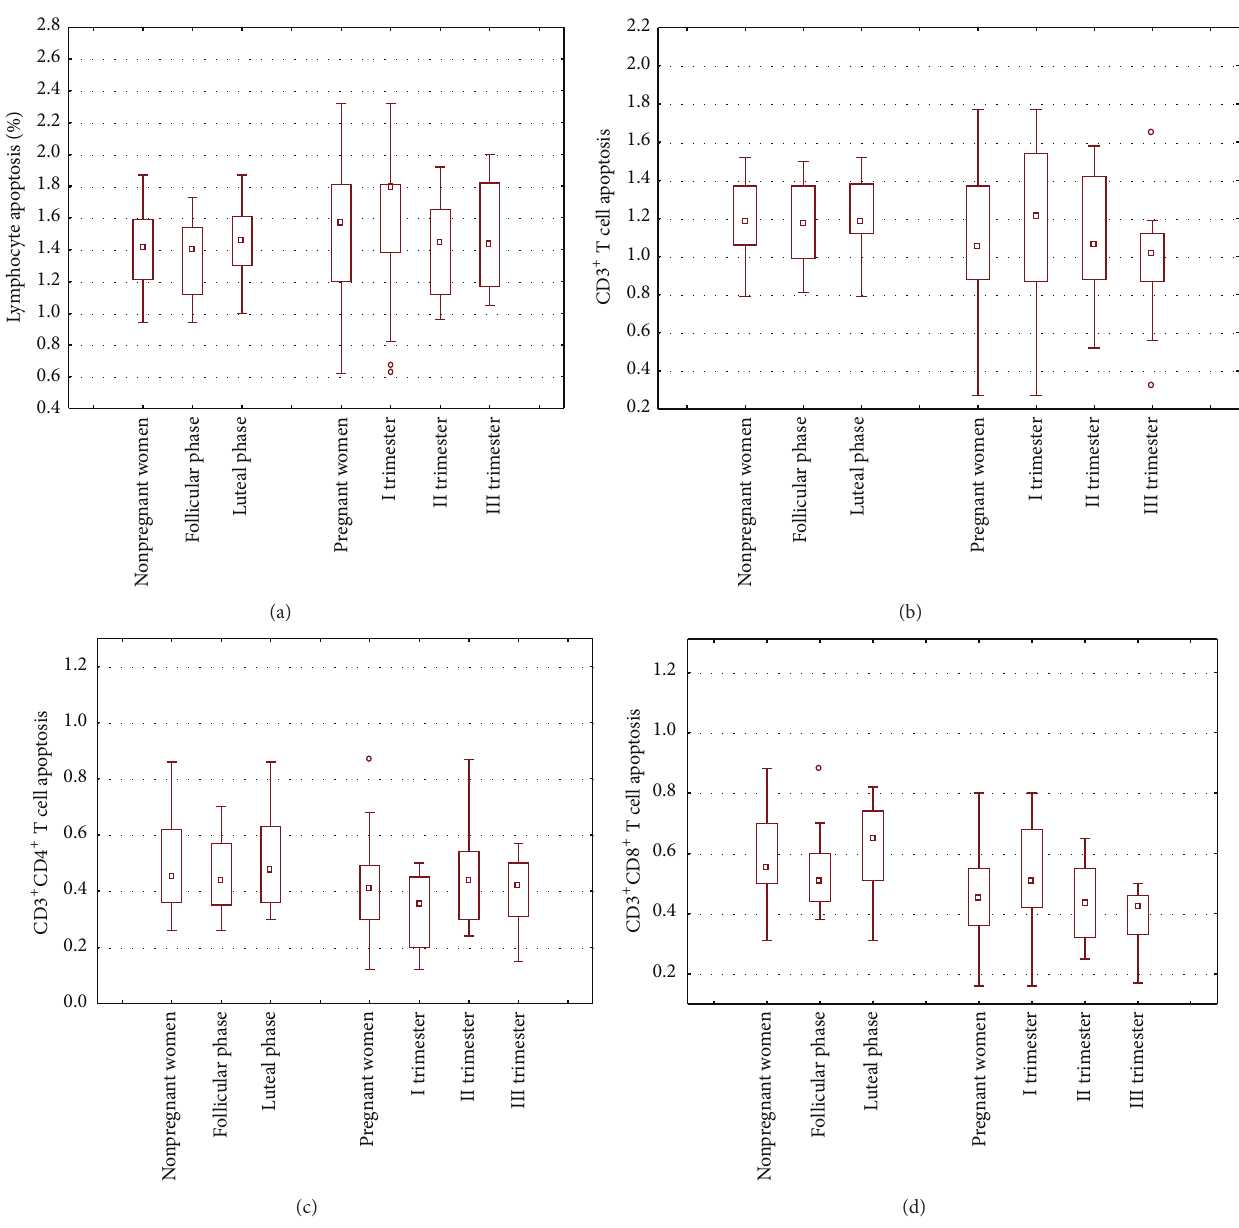
Figure 2: The percentages of total lymphocytes and T CD3 + , T CD3 + CD4 + , and T CD3 + CD8 + apoptotic lymphocytes; lymphocyte apoptosis in peripheral blood of women in the first ( 𝑛 = 20 ), second ( 𝑛 = 20 ), and third trimesters ( 𝑛 = 20 ) of normal pregnancy and in peripheral blood of healthy nonpregnant women in the phases of the menstrual cycle ( 𝑛 = 17 ).